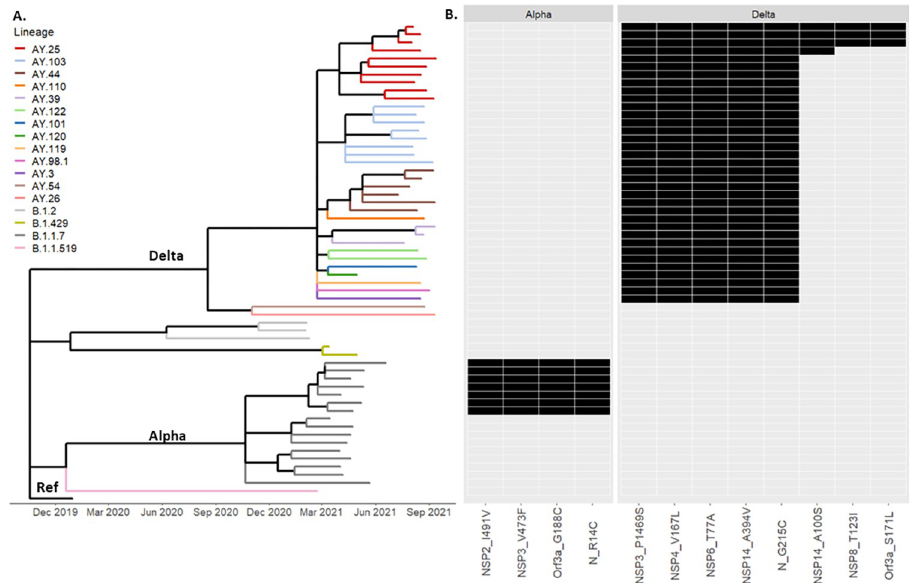
Fig 1. Lineages and mutations among SARS-CoV-2 vaccine breakthrough cases. (A) Time-scaled phylogeny of 59 SARS-CoV-2 genomes collected from vaccine breakthrough cases in Allegheny County, PA; Ref. Wuhan reference genome (MN908947). (B) Significantly enriched non-synonymous mutations among Alpha and Delta VOCs; black, present; white, absent. (Fig 1A). Thirty-seven genomes belonging to the Delta VOC comprised thirteen AY subli-